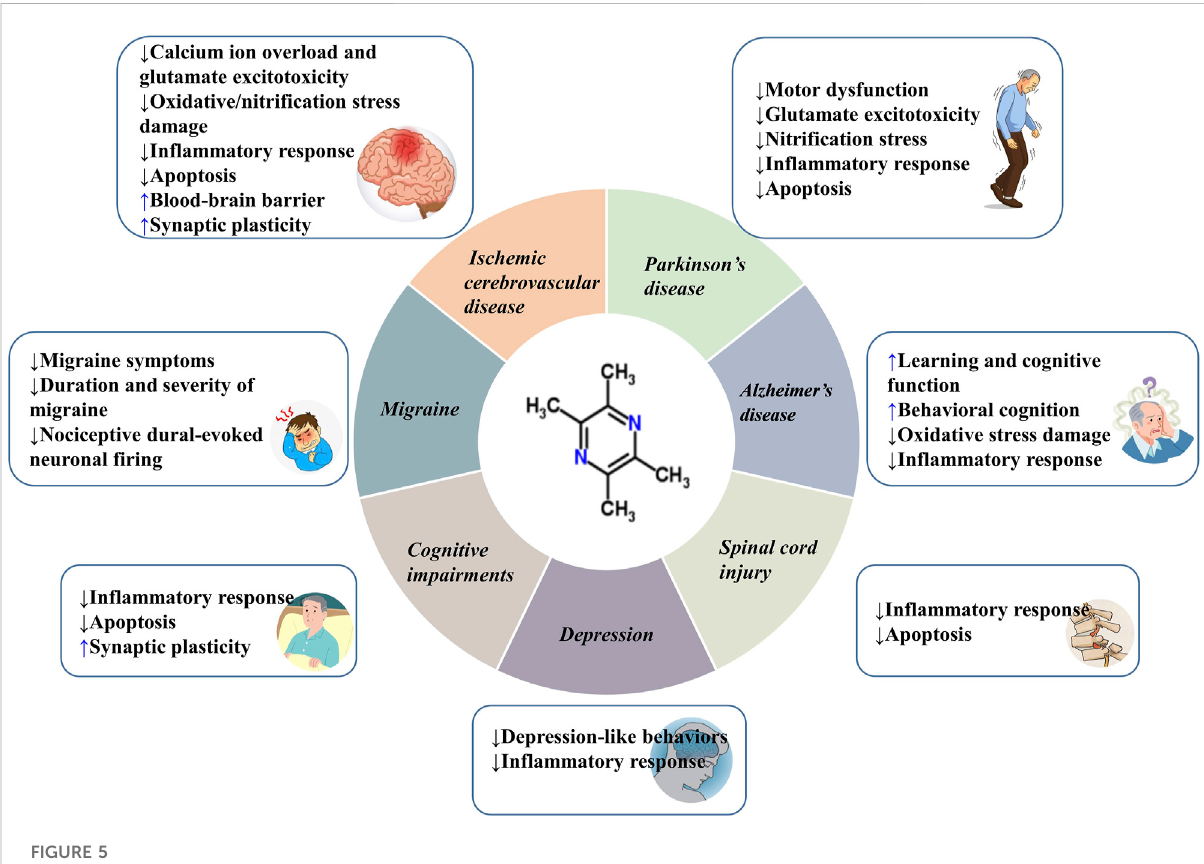
The bene fi cial efffects of TMP on CNS